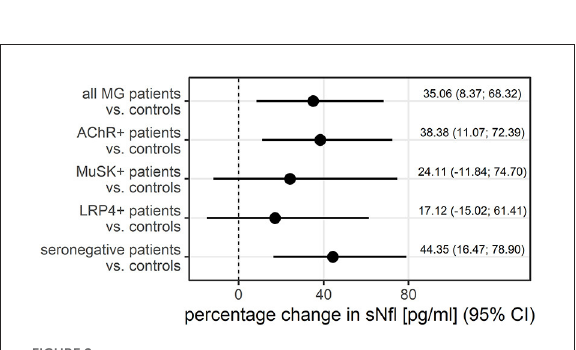
FIGURE2 The adjusted difference between patients with MG and controls additionally stratified by antibody status, displayed as the percentage change in sNfl, derived from log-linear regression adjusted for age and sex in a logistic regression. AChR– + , acetylcholine receptor antibody positive MG-patients, CI, 95% confidence interval, LRP4 + , lipoprotein related peptide 4 positive MG-patients, MuSK + , muscle specific positive MG patients, sNfl, serum neurofilament light